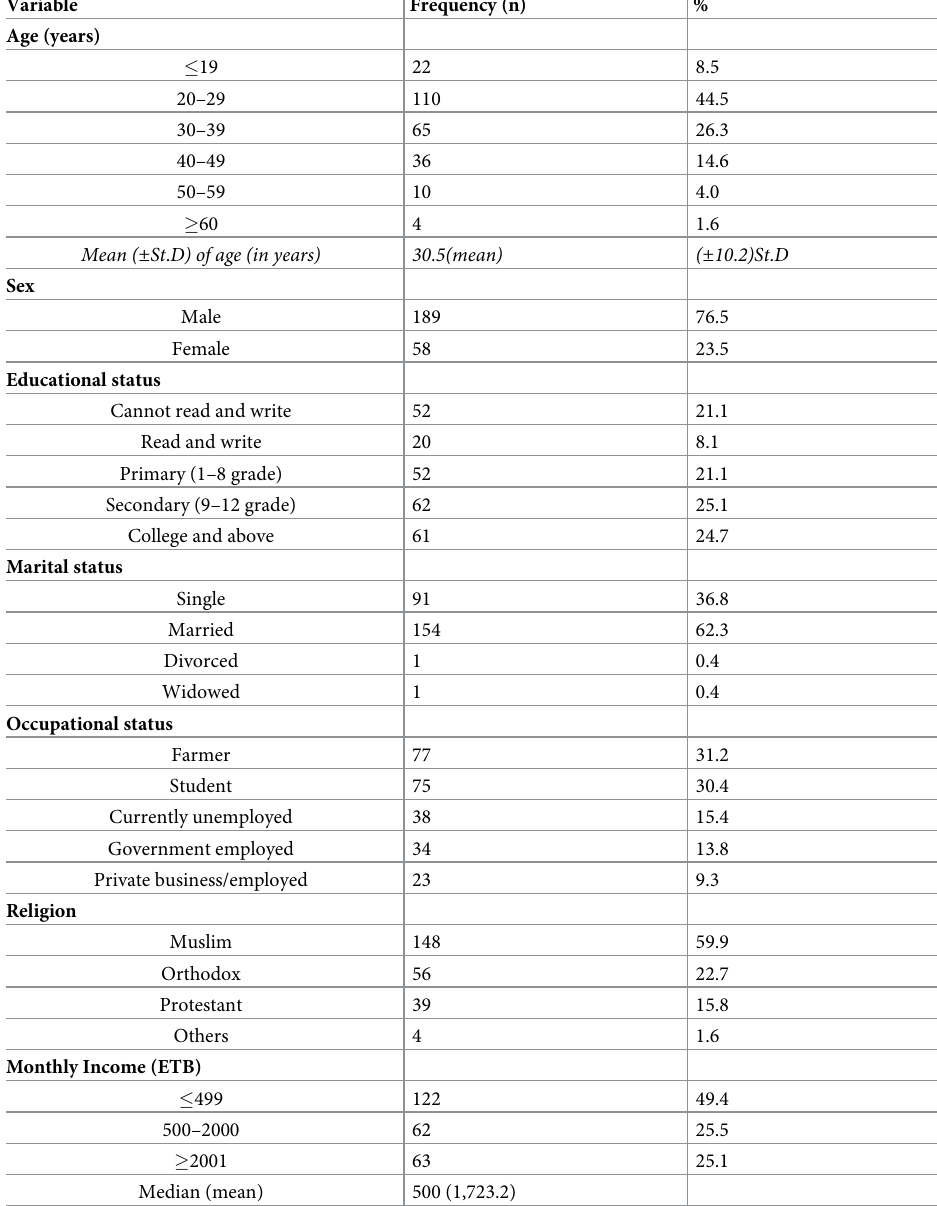
Table 1. Socio-demographic characteristics of JUMC visitors, Jimma, March 2020 (n = 247).